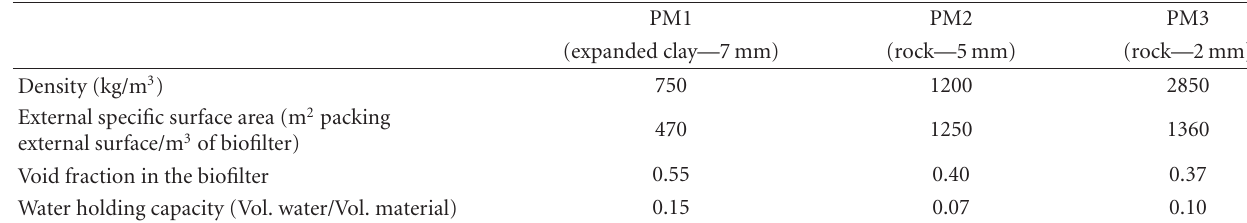
Table 1: Characteristics of the tested packing